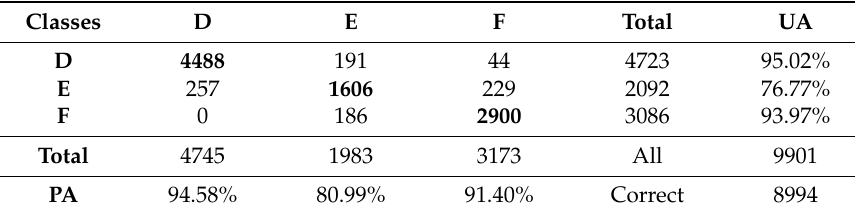
Table 4. Confusion matrix for the accuracy assessment (unit: